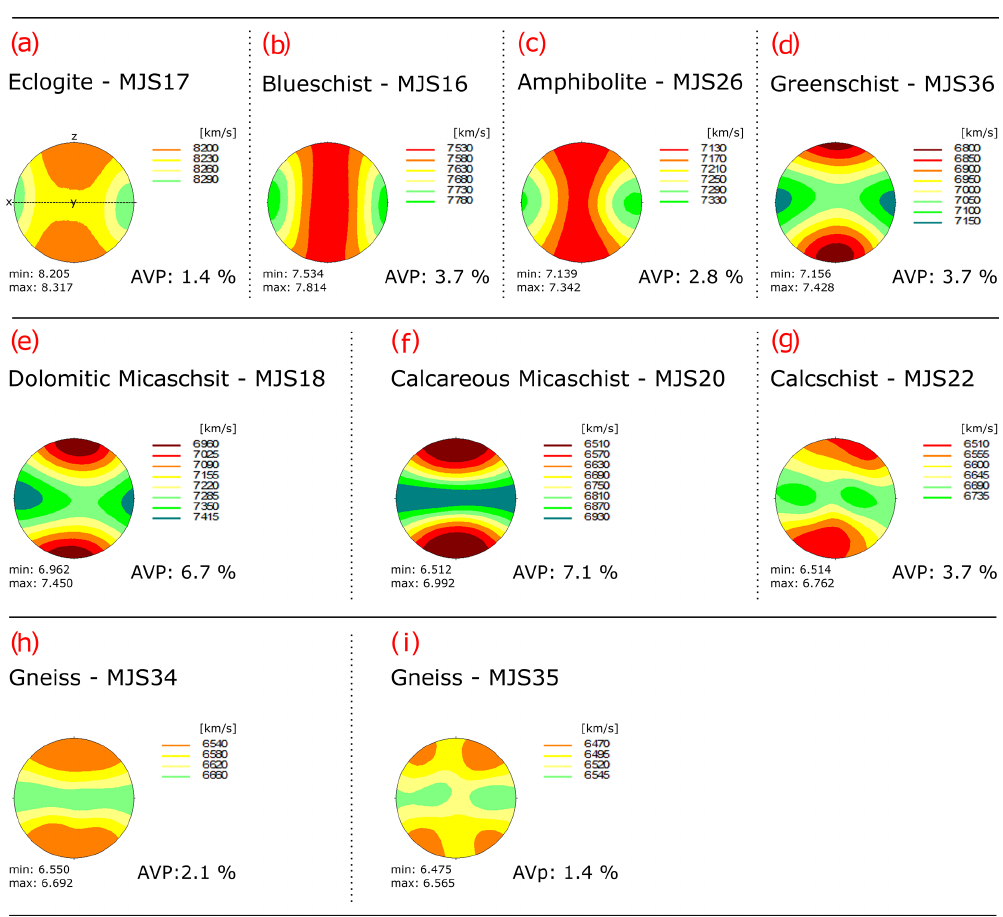
Figure 8. Texture-derived calculated P-wave velocity distributions of all samples in the study. All velocities in km/s with maximum and minimum values as well as P-wave anisotropy (in %) given below the pole